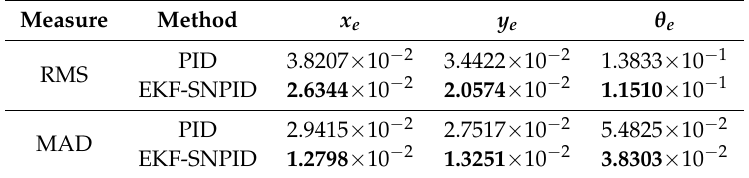
Table 4. Experimental results for the rose curve trajectory. The best results are highlighted in bold. Measure